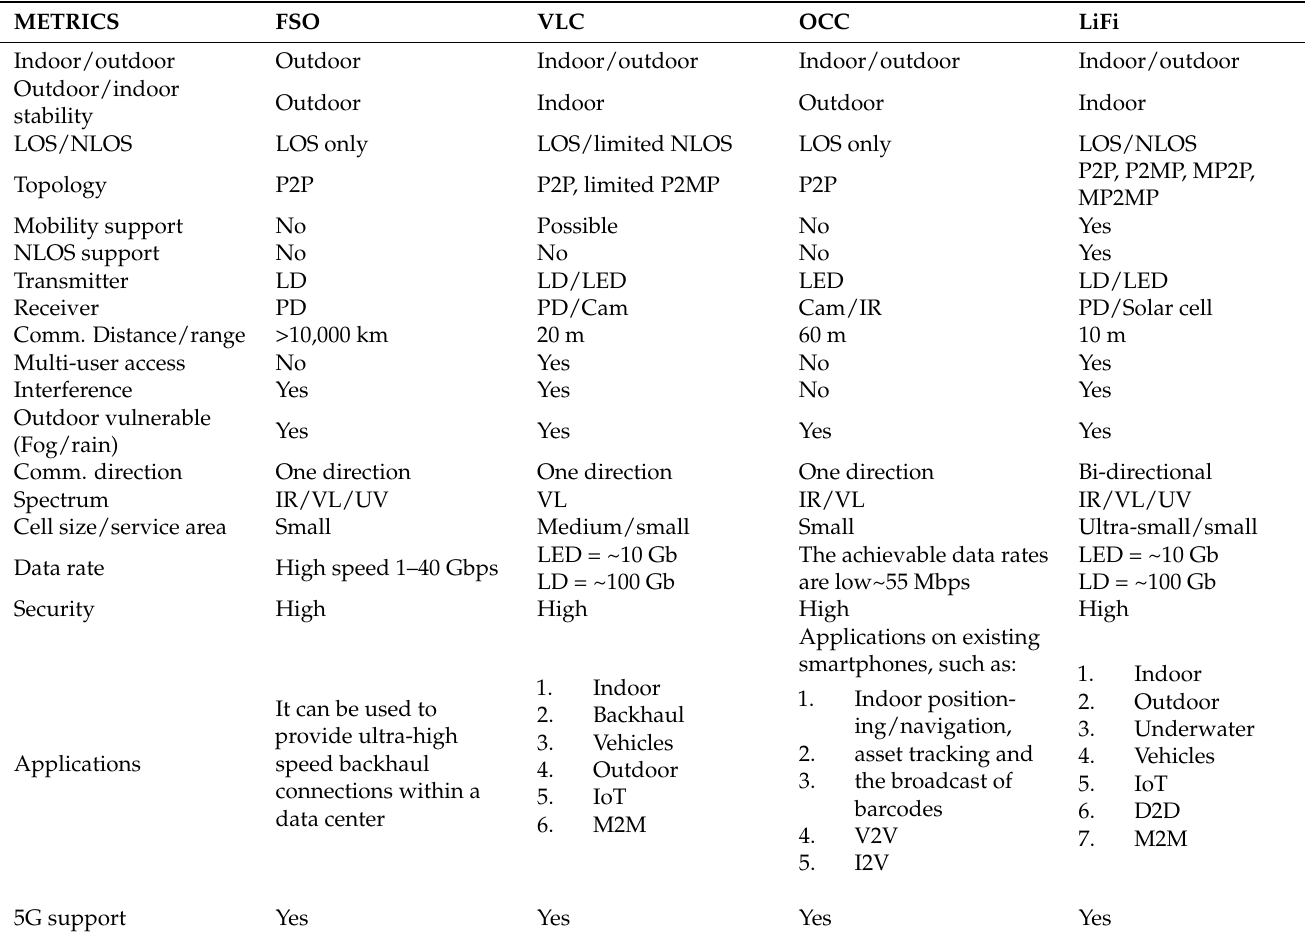
Table 4. LiFi and other OWC comparison